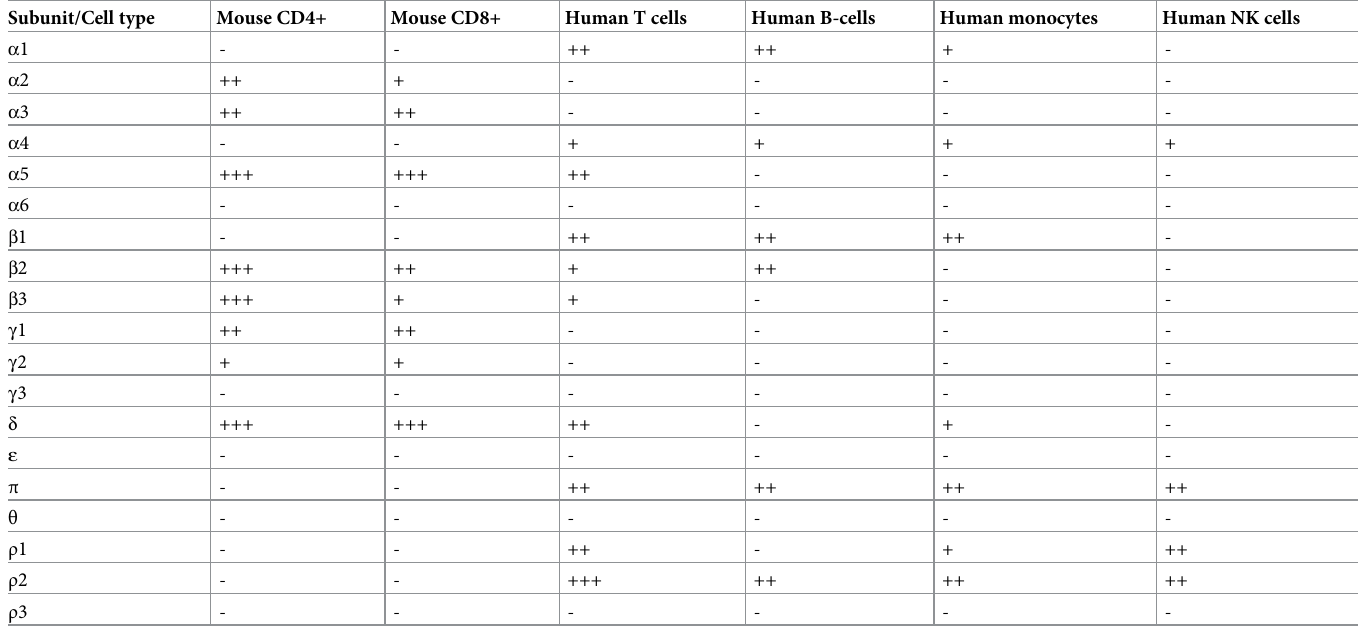
The expression levels indicated are based on the thickness and intensity of the bands in the gel. “+++” represents high level of expression, “++”—medium, “+”—weak expression and “- “–expression not